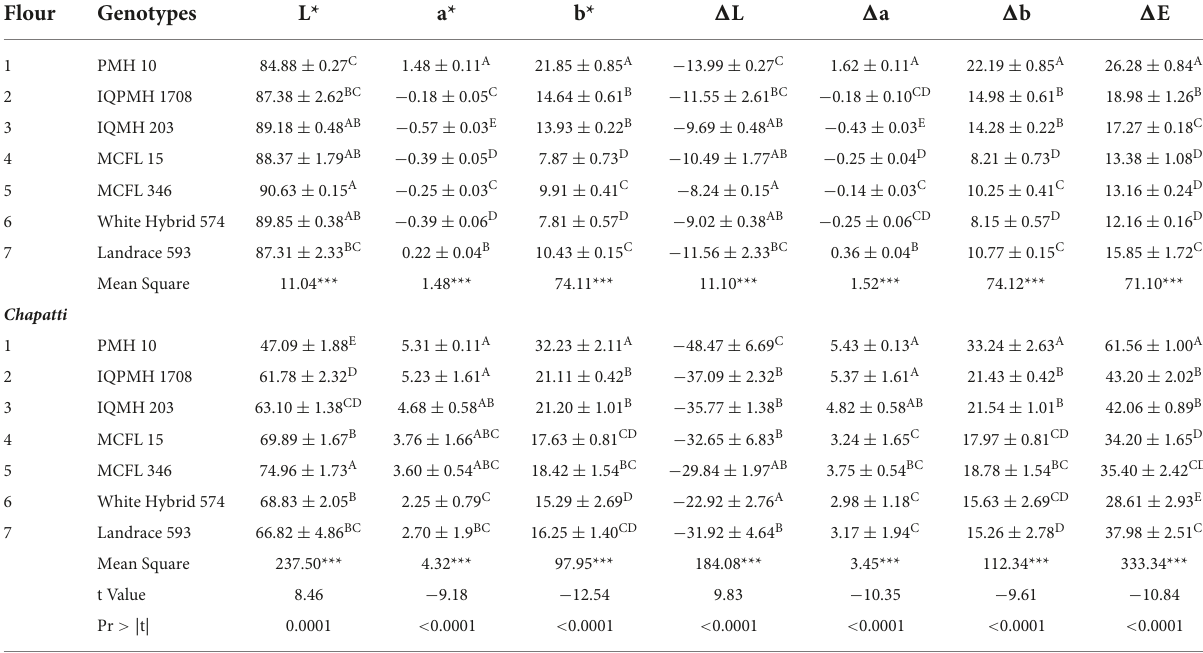
TABLE 5 Color analysis of maize flour and chapatti from different genotypes.